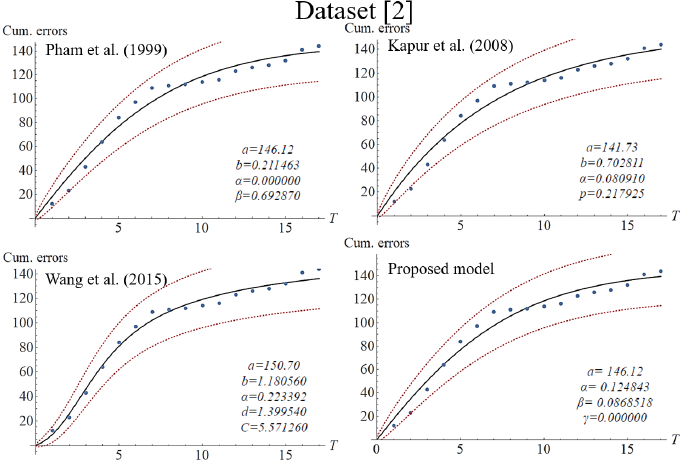
Figure 3. Goodness-of-Fit and Estimated Values of Models’ Parameters, and 95%Confidence Intervals for Dataset (2).